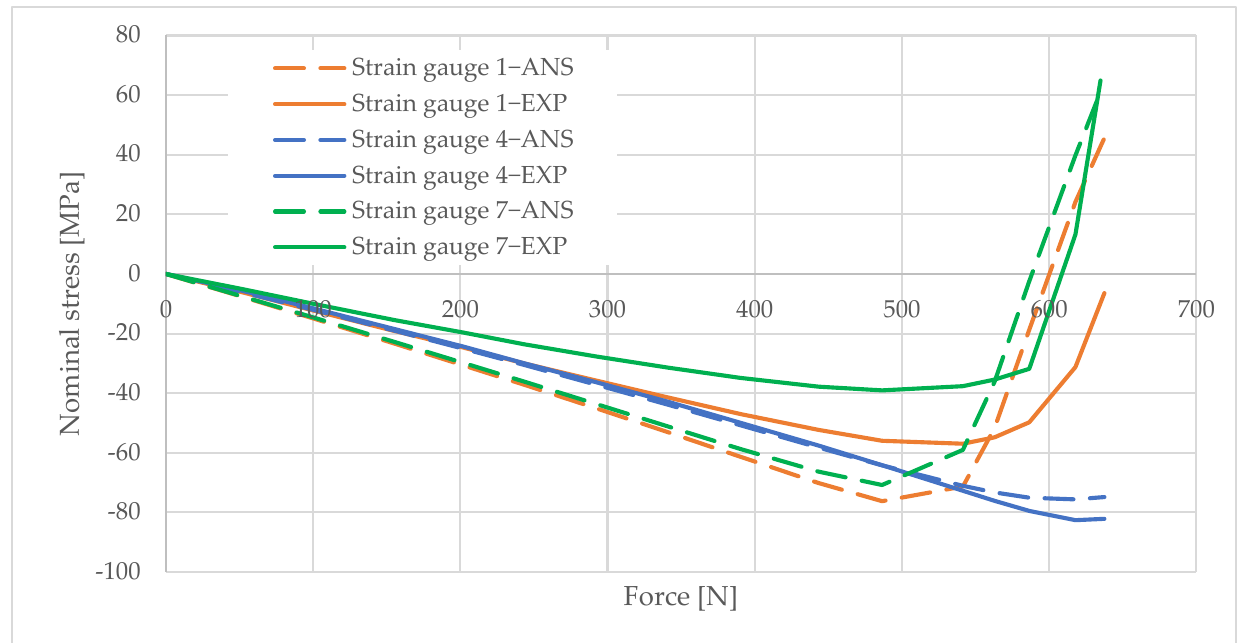
Figure 10. Pole 5/2 — values of normal stress readings from strain gauges no. 1, 4, and 7. Figure 10. Pole 5/2—values of normal stress readings from strain gauges no. 1, 4, and